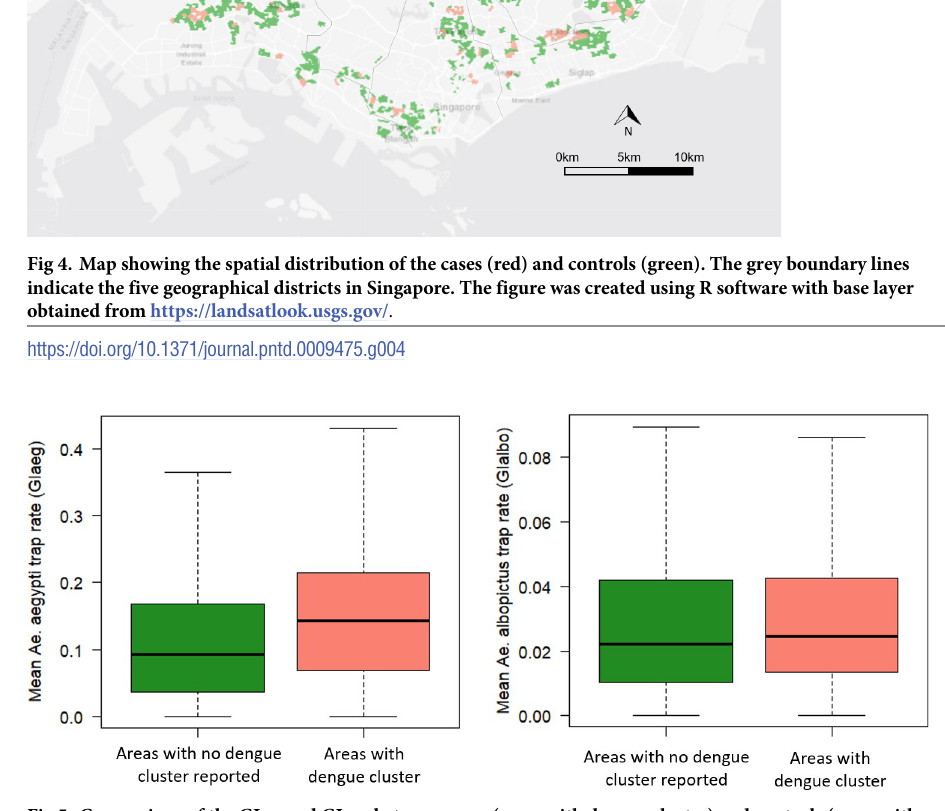
Fig 5. Comparison of the GI aeg and GI albo between cases (areas with dengue cluster) and controls (areas with no dengue cluster